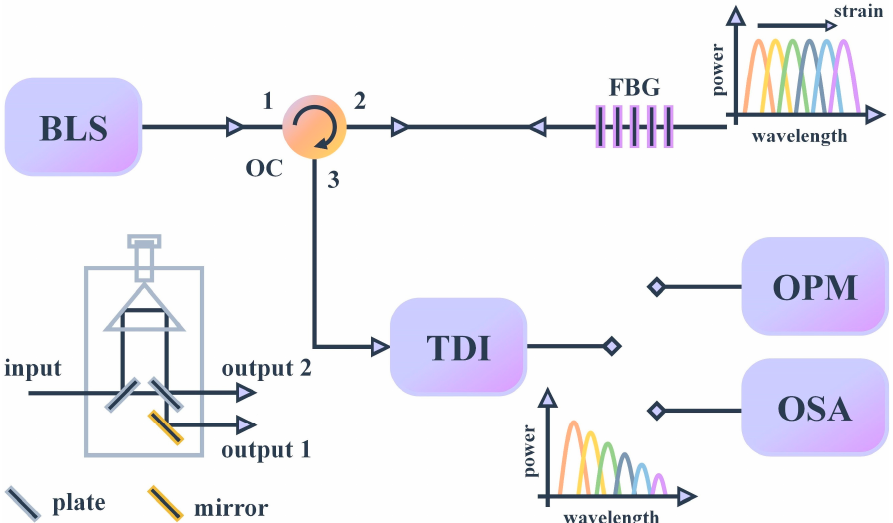
Figure 1. The proposed experimental setup and internal structure of the tunable delay line interferometer. The data acquisition in the experimental setup was made by first connecting outputs 1 and 2 of the tunable delay line interferometer (TDI) to the optical power meter (OPM) and optical spectrum analyzer (OSA) to measure power and record the spectra, then connecting output 2 to the OPM to measure power. The broadband light source (BLS) feeds the fiber Bragg grating (FBG) strain sensor through the optical circulator (OC). The reflected wave is modulated by a TDI and detected by an OPM and an OSA. The wavelengths and power changes of the FBG without and after the TDI under different strains are shown in the upper and lower right corners, respectively.